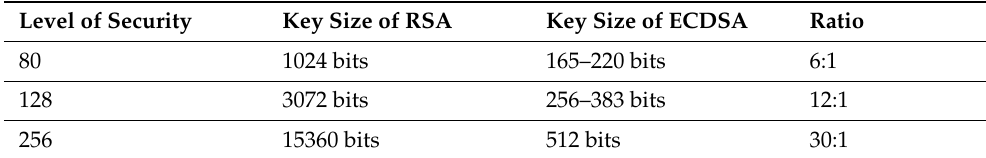
Table 7. Comparison of key sizes between RSA and